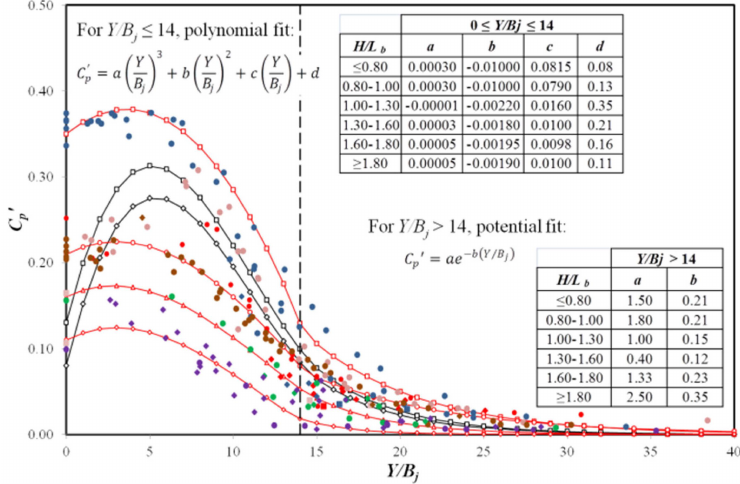
Figure 5. Fluctuating dynamic pressure coefficient ( C p ' ) for the nappe flow case in function of ratios Y / B j and H / L b (Castillo et al.